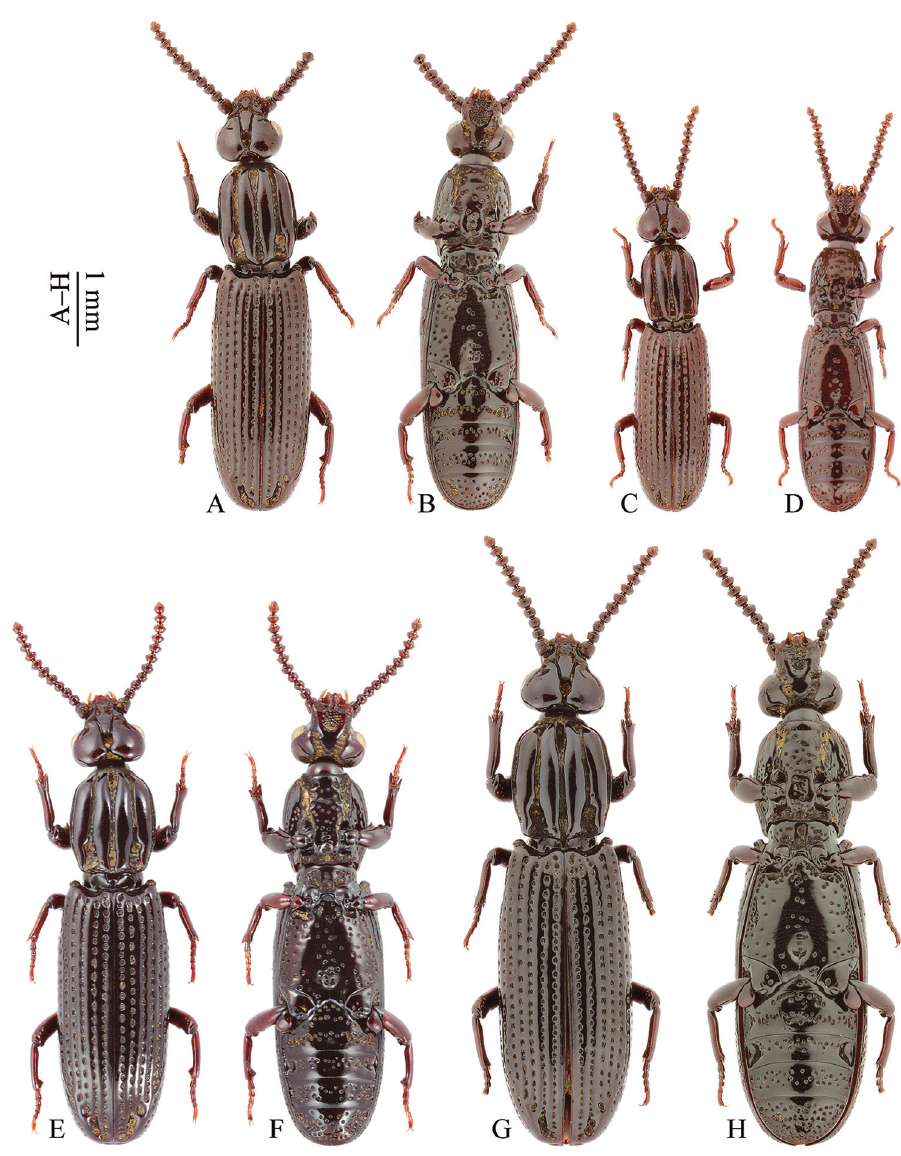
Figure 1. Habitus of Omoglymmius ( s. str. ) spp. from East Asia. A–D O. ( s. str. ) sakuraii (Nakane, 1973) (Vietnam: Tam Dao A–B ♂ C–D ♀ ) E–H O. ( s. str. ) laticeps Bell, 1977 ( E–F Bhutan: Thimphu ♂ G–H holotype ♀ ). ( A, C, E, G dorsal view B, D, F, H ventral view). line; more coarse punctures closely arranged almost into a row near lateral margins; remainder of disc smooth; a shallow median pit present posteriorly (Figs 2B, D; 3G). Aedeagus with right paramere simply curved at outer margin and expanded in apical part (Fig. 6E). Female profemur without tooth on ventral side (Fig.